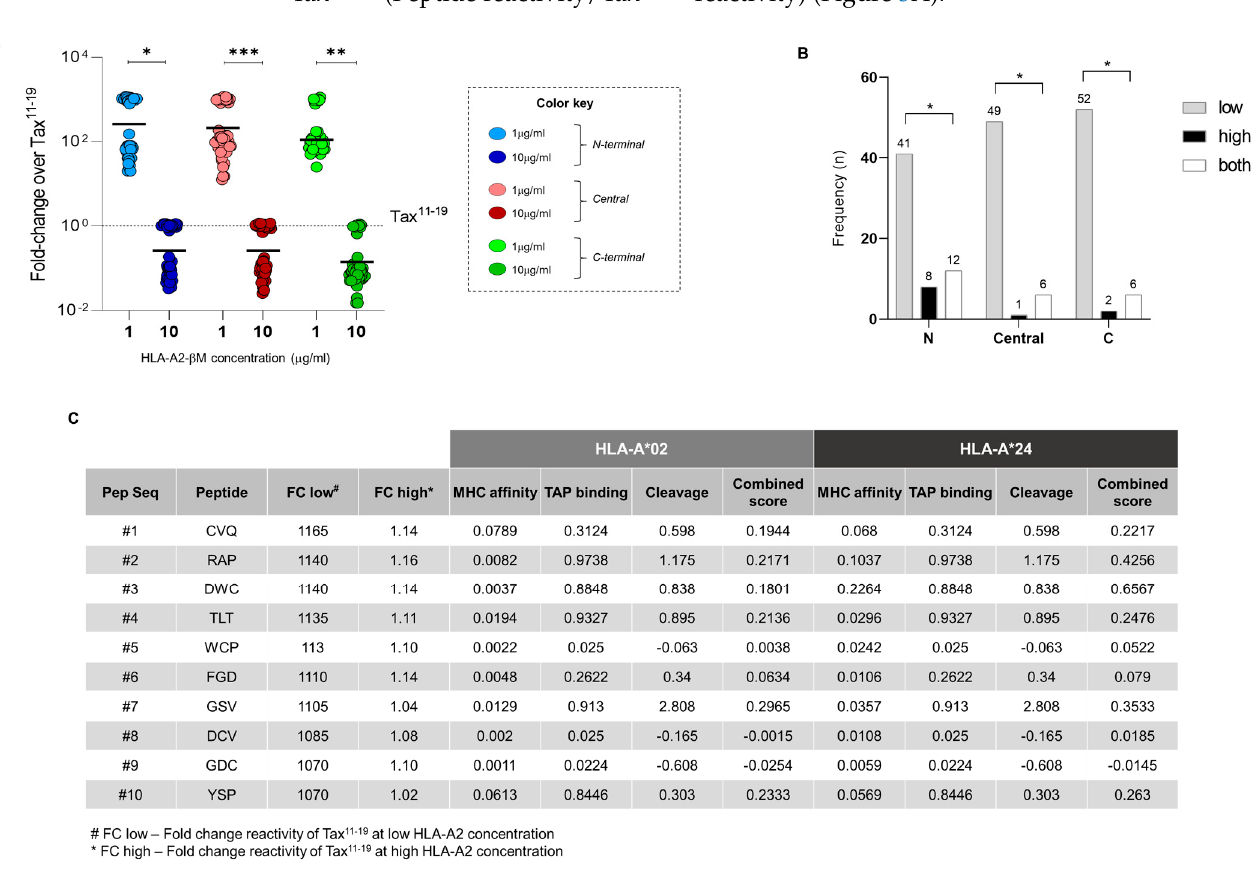
Figure 3. Reactivity of Tax peptides according to immunodominant Tax 11-19 peptide. Reactivity of HLA-A*02:01 haplotype-restricted peptides compared with Tax 11-19 reactivity. ( A ) Scatter-plot representation of HLA-A*02:01-restricted peptides at a concentration of 1 and 10 µg/mL distributed among the three regions of Tax: N-terminal, Central and C-terminal. ( B ) Number of peptides located in the N-terminal, Central and C-terminal regions of Tax that showed greater reactivity than Tax 11-19 , considering low, high and both HLA-A*02 concentrations. Connecting lines with asterisks show statistical differences at p <0.05 (* indicates p ≤ 0.05; ** indicates p ≤ 0.01; *** indicates p ≤ 0.001), using Chi-square statistical test. ( C ) Representative table of the top 10 Tax peptides whose reactivity was greater than Tax 11-19 with in silico prediction data for HLA-A*02 and HLA-A*24 haplotypes.